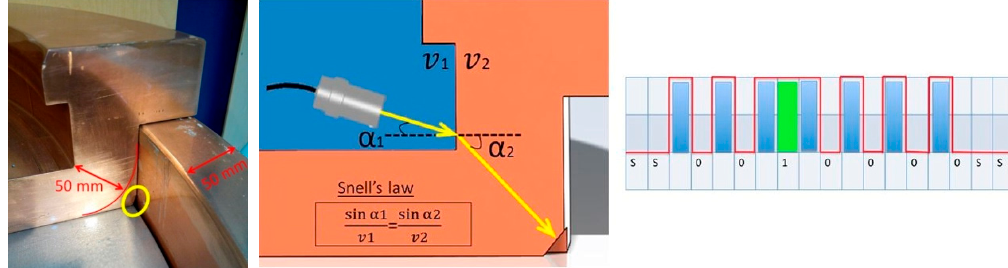
Figure 13. The ultrasonic investigation of chamfers, artificially machined on canisters’ lid to create a unique identification fingerprint.